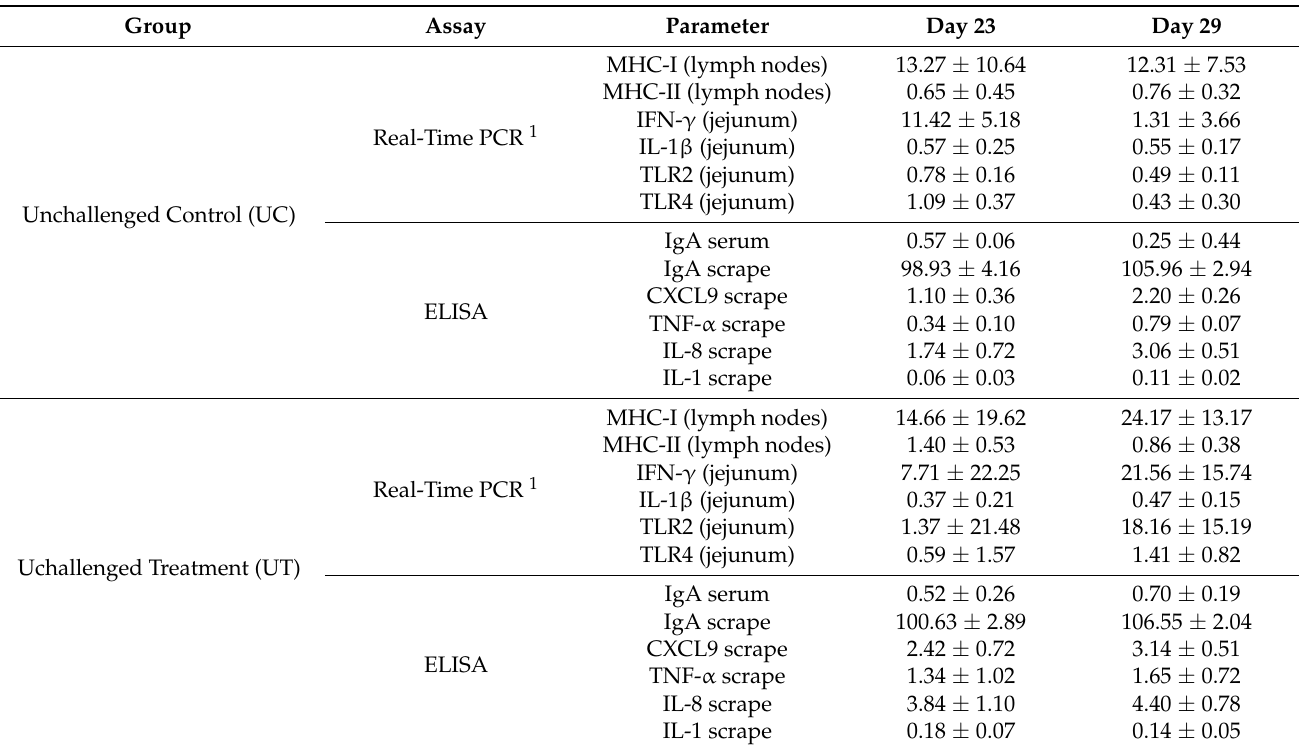
Table 6. Mean values obtained from real-time PCR and ELISA tests at 23 and 29 days divided by the experimental